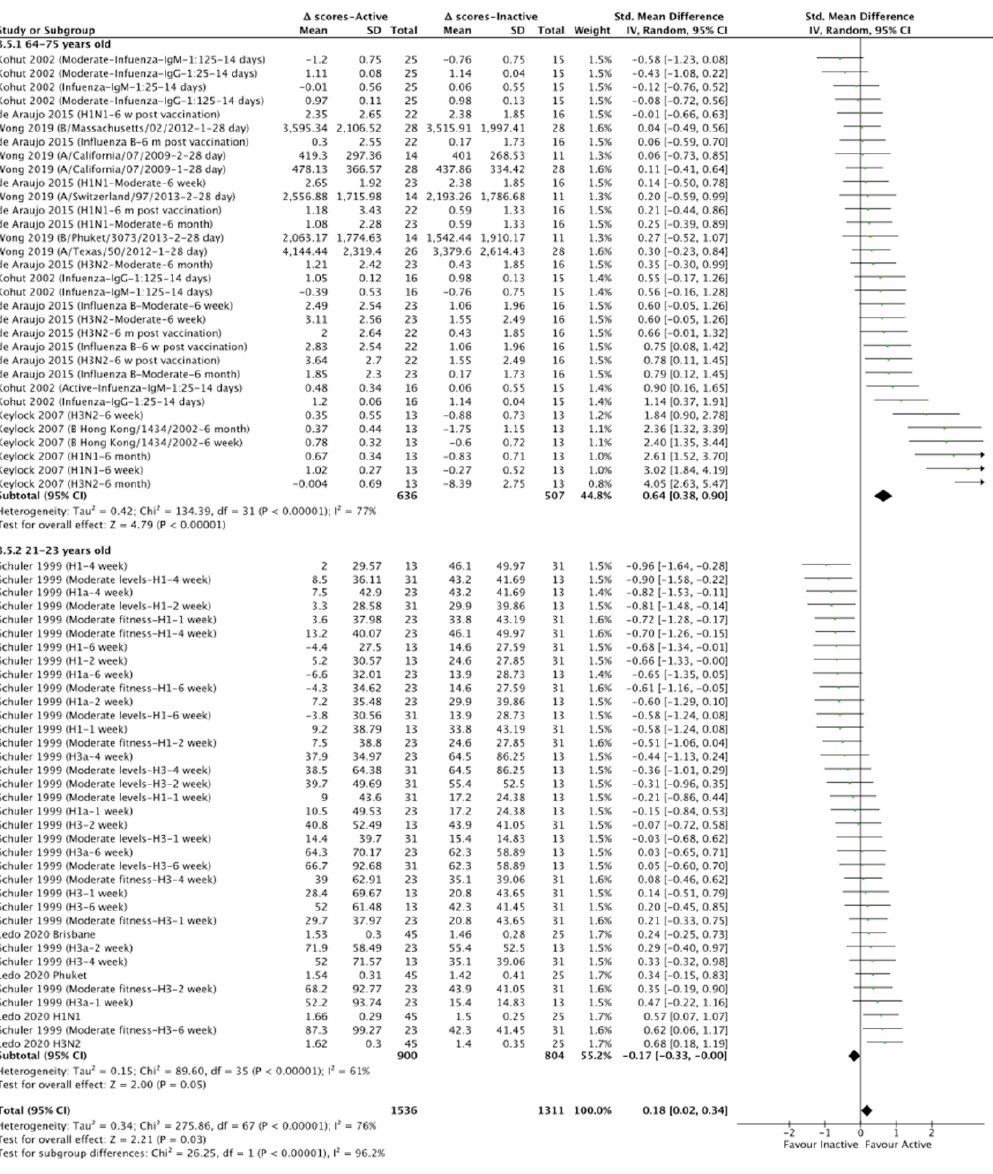
Figure 3. Forest plot of the effect of physical activity levels on influenza vaccine antibodies (sub- group analysis for age). Δ scores: post intervention–baseline; SD: standard deviation; 95% CI: 95% confidence interval.